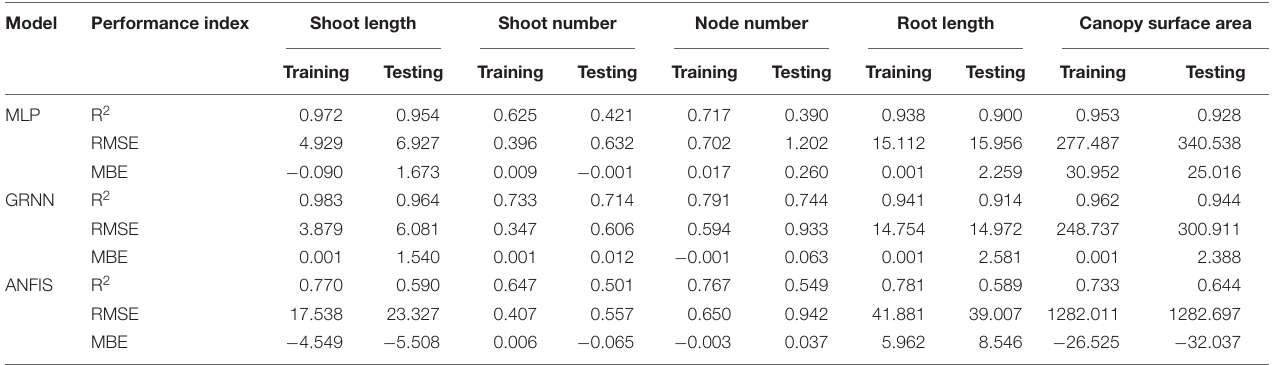
TABLE 2 | Performance indices of different machine learning algorithms (MLP, GRNN, and ANFIS) for modeling and predicting shoot length, root length, number of nodes, number of shoots, and canopy surface area of Cannabis .